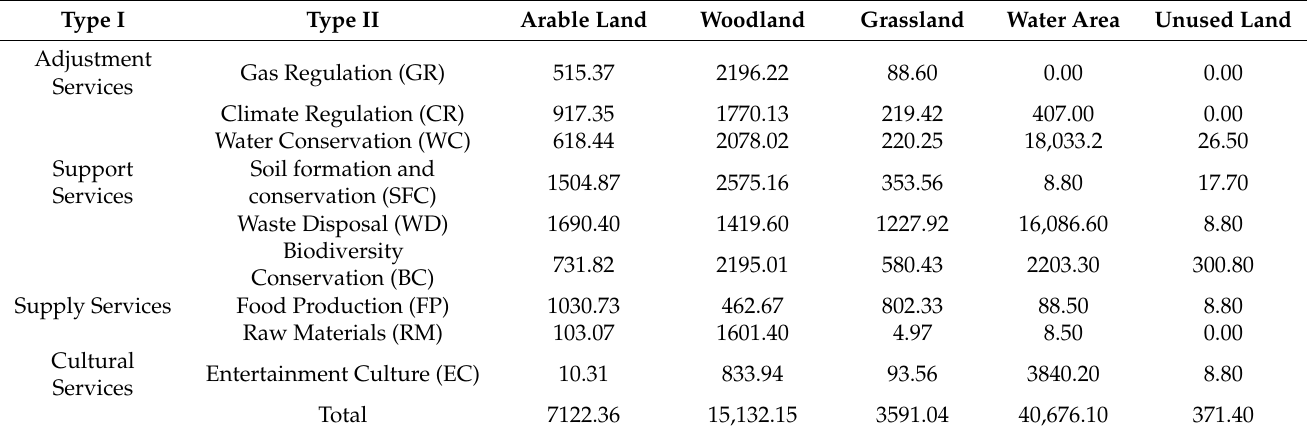
Table 1. Table of ecological service value equivalents per unit area of terrestrial ecosystems in the Qihe watershed (CNY/ha) as used in this study